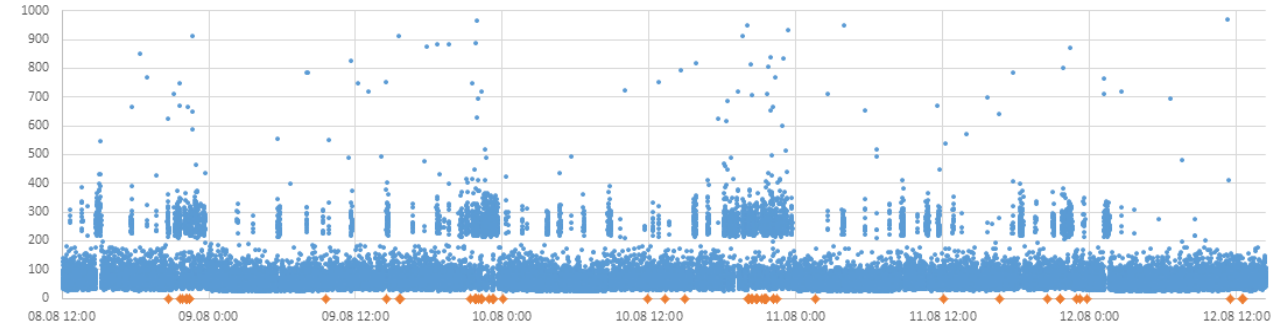
Fig. 14. RTT of heavily loaded Tele2 3G second endpoint (Google free DNS), ms.